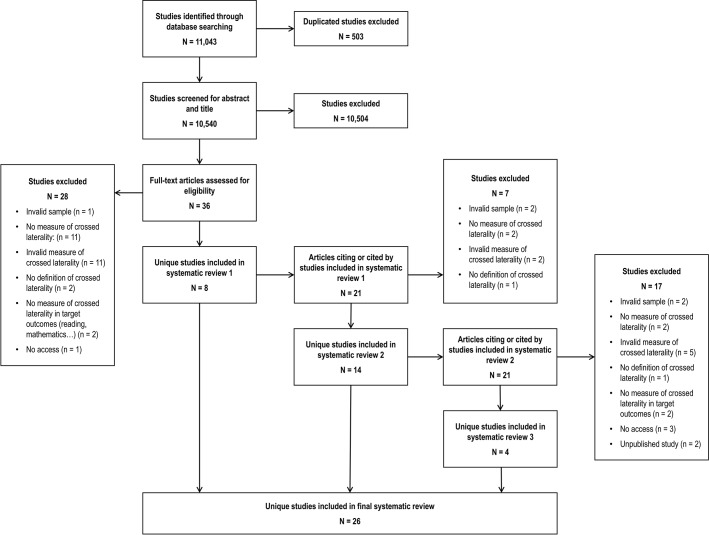
PRISMA flowchart.